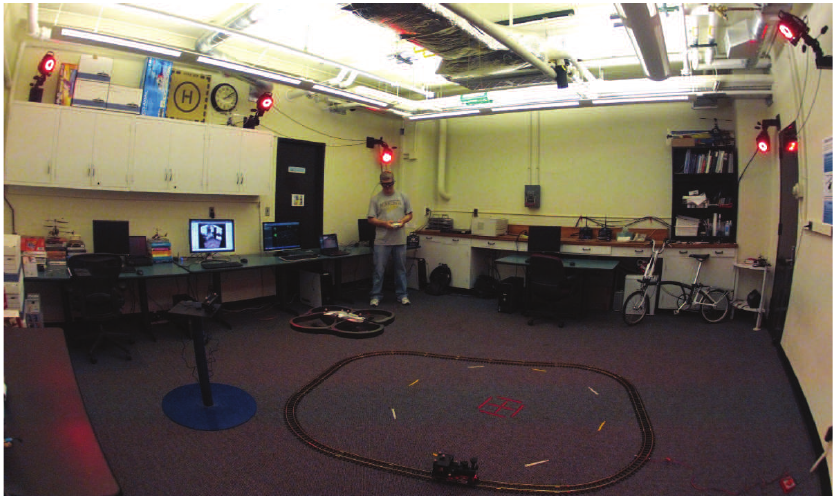
Figure 1. Lab facility for investigating human perception–action using a miniature unmanned aerial vehicle (UAV) with motion and gaze